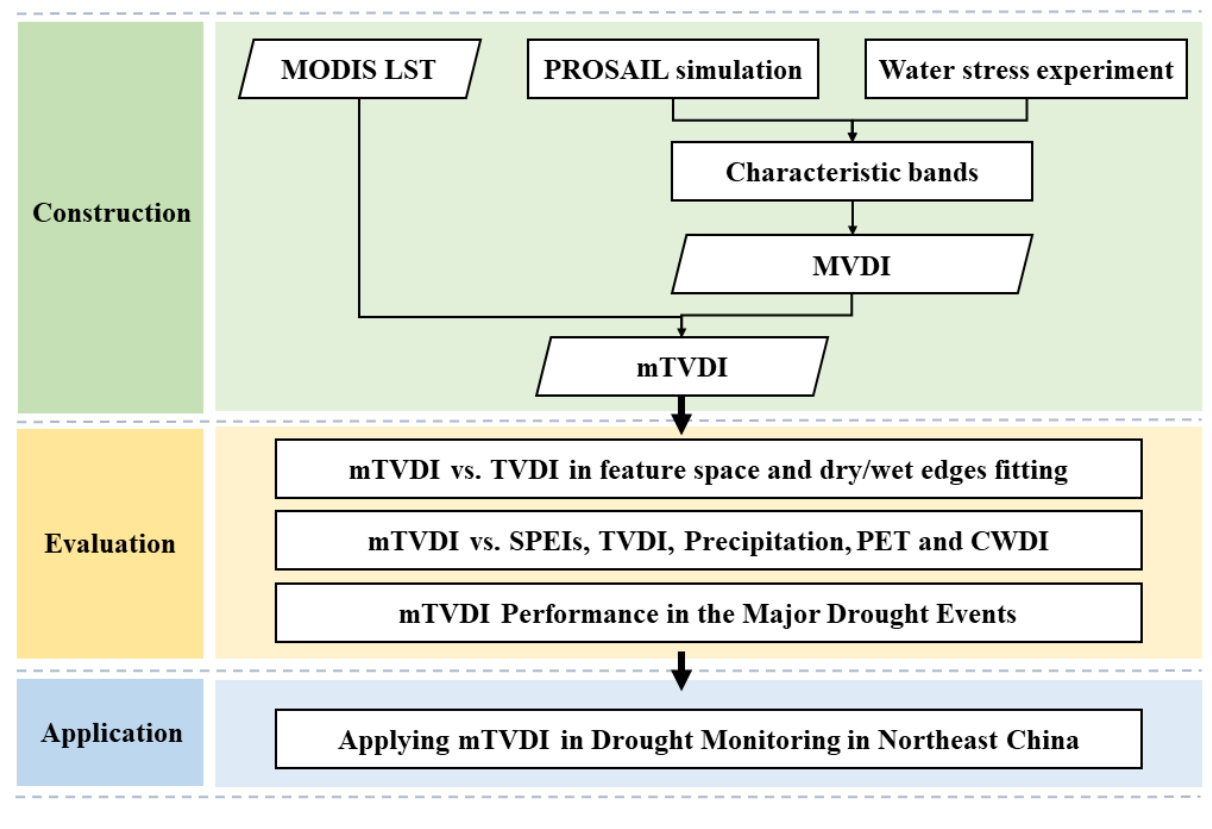
Figure 2. Flowchart of the study.